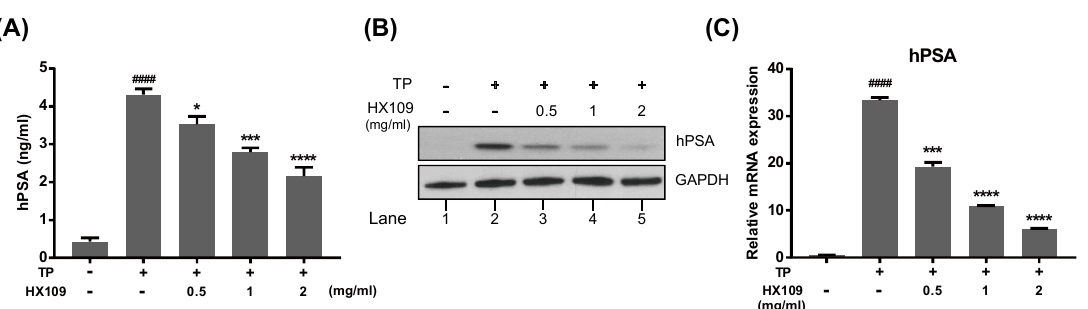
Figure 4. HX109 inhibited the androgen-induced PSA (KLK3) expression in LNCaP cells. LNCaP cells were treated as described in Figure 3. ( A ) Effects of HX109 on hPSA protein secretion were analyzed by ELISA after 24 h. #### p < 0.0001 (one-way ANOVA) compared with control, * p < 0.05, *** p < 0.001, **** p < 0.0001 (one-way ANOVA) compared with TP only. ( B ) Effects of HX109 on hPSA protein expression. After 48 h, protein levels in cell lysate were analyzed by western blot. ( C ) Effects of HX109 on hPSA mRNA expression. The RNA levels were analyzed by quantitative RT-PCR after 24 h. Values were normalized to GAPDH for both protein and RNA analysis. #### p < 0.0001 compared with control, *** p < 0.001, **** p < 0.0001 (one-way ANOVA) compared with TP only. All data are represented as mean ± S.E.M. of three independent experiments. ‘+’ means ‘treated with TP or HX109’, if it is on the right side of TP, it means ‘treated with TP’; if it is on the right side of HX109, it